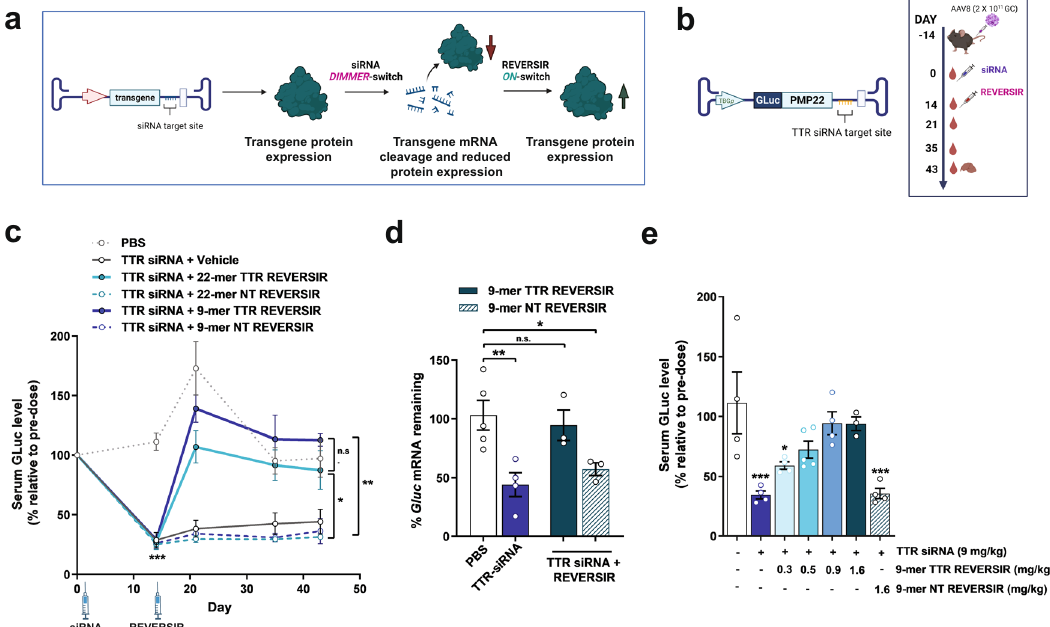
Fig. 3 | In vivo regulation of an AAV-expressed reporter transgene by exogen- ous delivery of siRNA and REVERSIR. a Diagram depicting dual agent approach involving suppression of AAV transgene expression with siRNA and subsequent upregulation of proteinexpression byabrogation of siRNA activity with REVERSIR. b Mice were injected with 2×10 11 GC of AAV encoding bicistronic expression of a GLuc reporter with a TTR siRNA binding site in the 3 ’ UTR. Mice were sub- cutaneously injected with vehicle or TTR siRNAat9mg/kg (D0). This was followed onD14withasinglemolarequivalentdoseoffull-length22-mer(3mg/kg)or9-mer TTR REVERSIR (1.6mg/kg) and compared to NT REVERSIR control. c Serum GLuc levels normalized to pre-dose (D0) for each animal ( n =5 for PBS; n =4 for vehicle and 22-mer TTR REVERSIR groups; n =3 for 22-mer NT REVERSIR and both